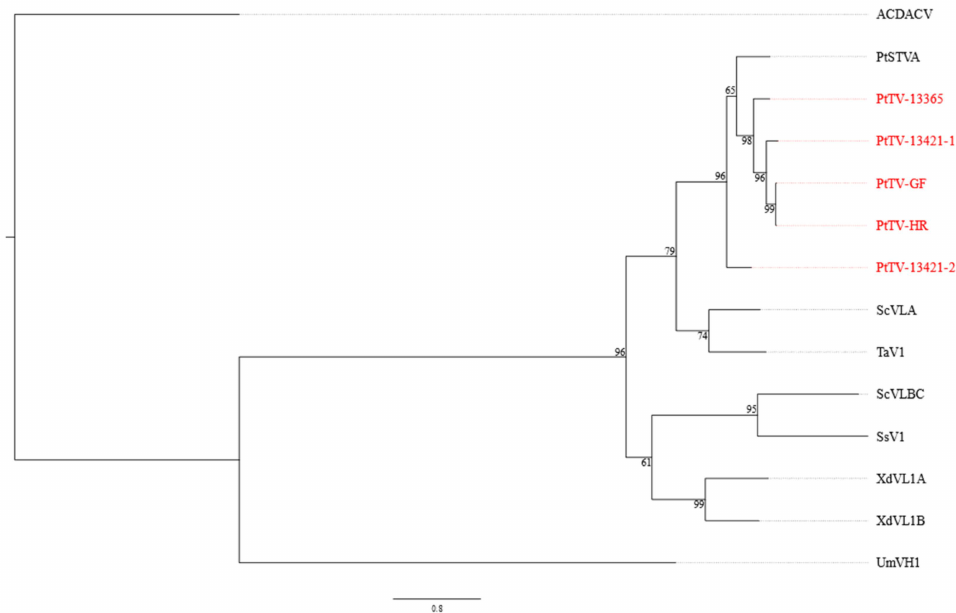
Figure 6. Maximum likelihood reconstruction of the phylogeny of totiviruses based on the RNA- dependent RNA polymerase gene. The acronyms in red font correspond to the viruses s discovered in this study (Table 1) and the other virus acronyms are defined in Table S6. The numbers next to the branches are non-parametric bootstrap values based on 1000 replicates. The nucleotide substitution model used for the phylogenetic tree is listed in Table